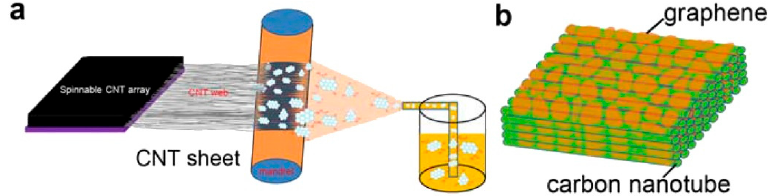
Figure 3. Schematic plot of CVD and the spray-coating process ( a ), and the obtained free-standing CNT array/GO composite films ( b ). Reprinted from [54] with permission; Copyright 2017 Elsevier.